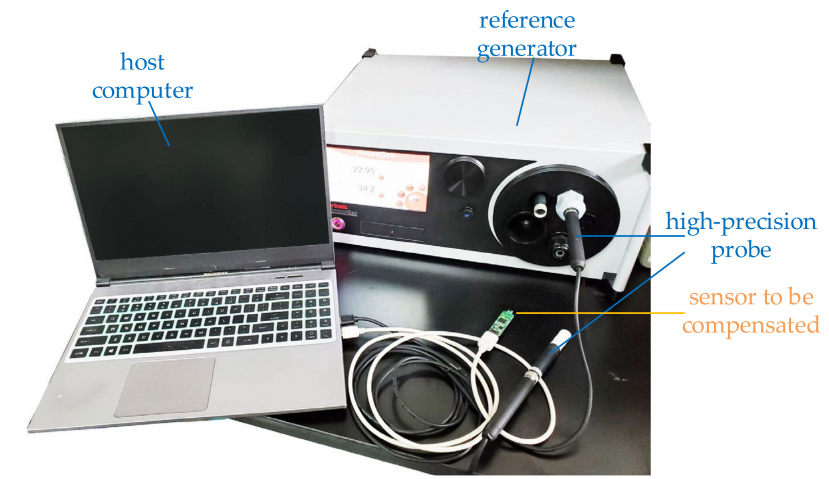
Figure 11. The experimental environment includes an integrated temperature and humidity sensor to be compensated, a reference generator for generating a stable temperature and humidity calibration environment, a high-precision probe for calibrating ambient temperature and humidity, and a host computer for data collection.